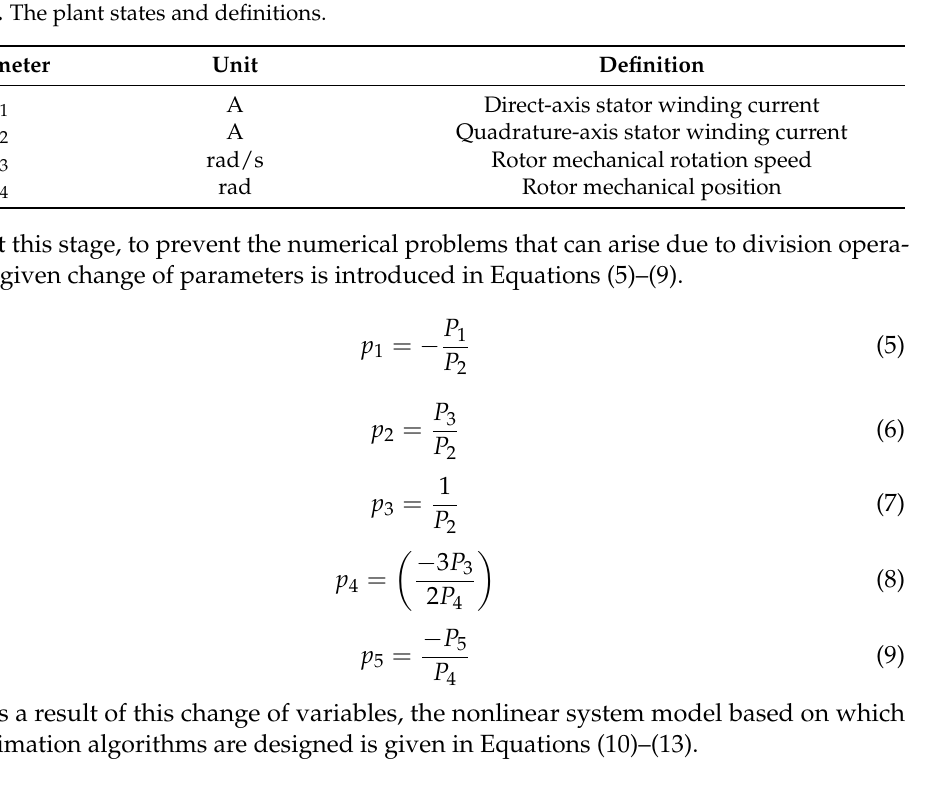
Table 1. The plant parameters and definitions. Parameter Unit Definition P 1 Ω Winding resistance P 2 H Winding inductance P 3 - Magnetic flux constant of the motor P 4 kg m 2 Moment of inertia of the rotor and the load P 5 - Viscous friction constant of the rotor